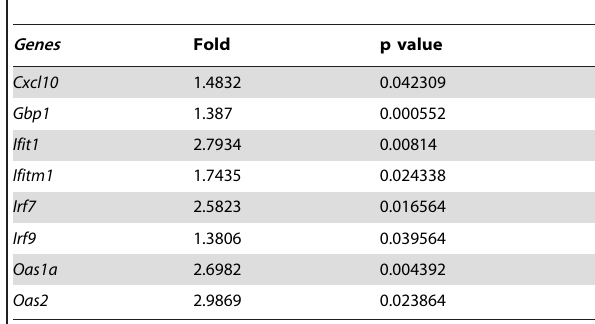
Table 1. Significantly induced genes in Dicer d/d splenocytes.